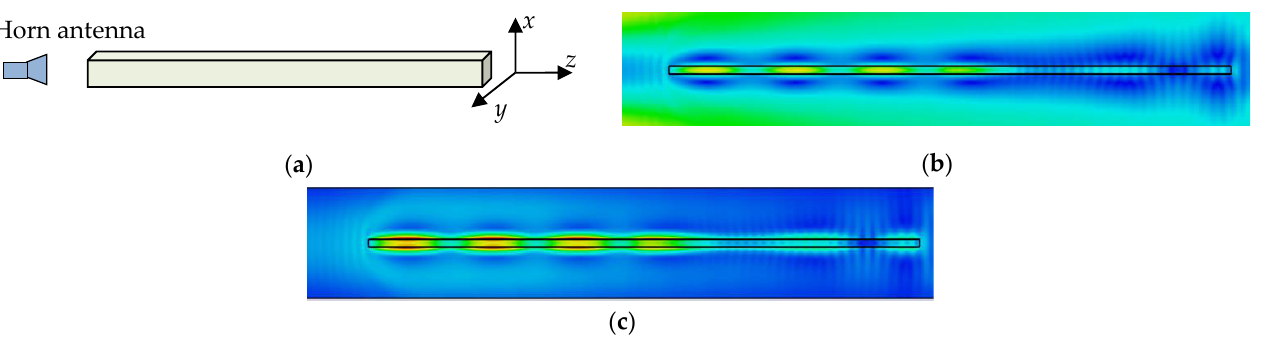
Figure 4. Beat wave pattern under excitation of horn antenna ( a ) simulation model of a dielectric bar illuminated by a horn antenna ( b ) field distribution on x = 0 plane ( c ) field distribution on y = 0 plane.